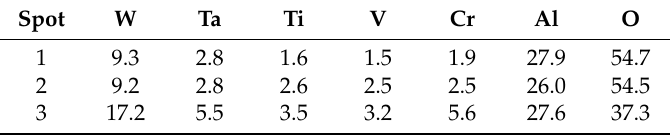
Figure 6. Sliding wear test of W 0.5 (TaTiVCr) 0.5 alloy at 400 °C showing ( a ) coefficient of friction (COF) versus sliding distance plot, ( b ) wear scar on alumina counterball, ( c ) wear track morphology and its magnified image in ( d ). Table 4. EDS analysis on counterball and wear track in Figure 6 in at. %.